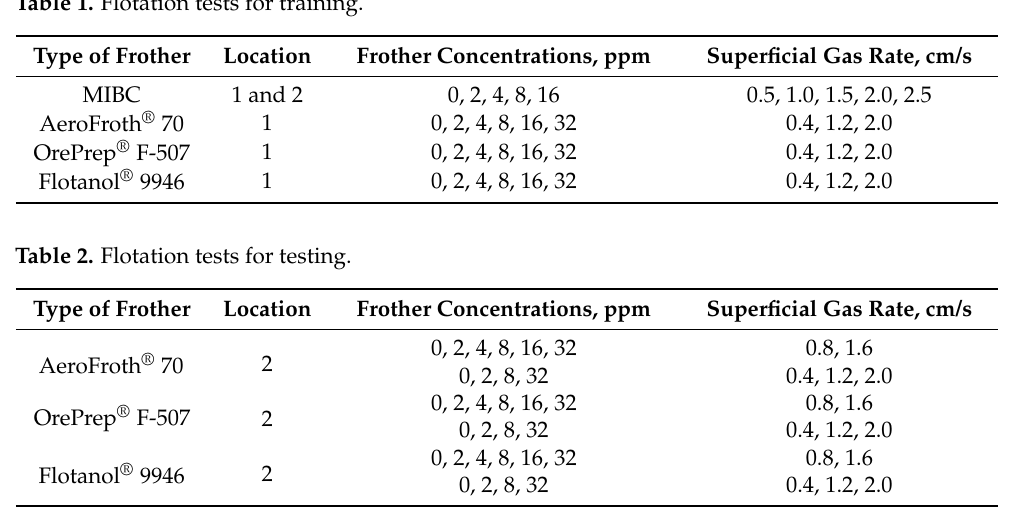
Table 1. Flotation tests for training.